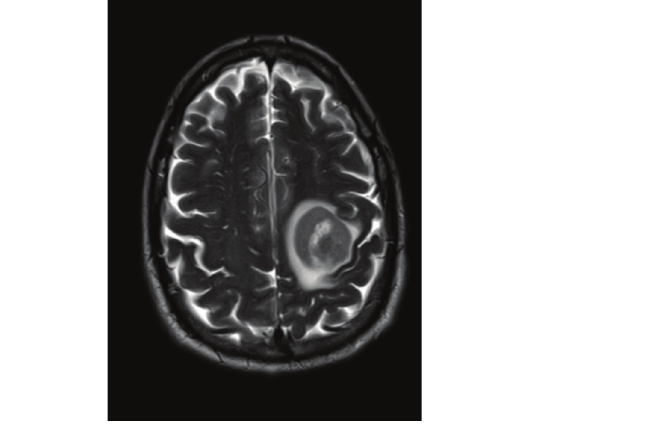
Figure 1: MRI of the brain showed a large mass in the left frontal area T2/FLAIR. Mild surrounding vasogenic edema and mass effect.